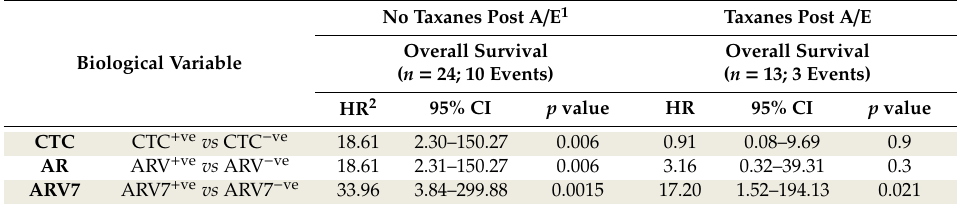
Table 3. Univariable analysis for OS as a function of biological variables in patients treated or not with